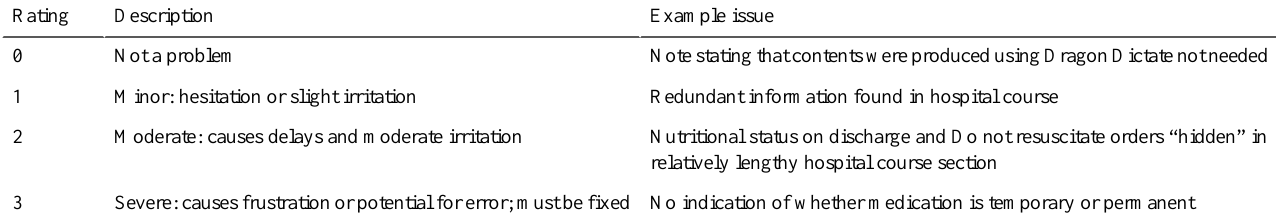
Table 1. Descriptions of the 4 levels used to rate the severity of issues found in simulated discharge summaries and examples of issues at each level. Example